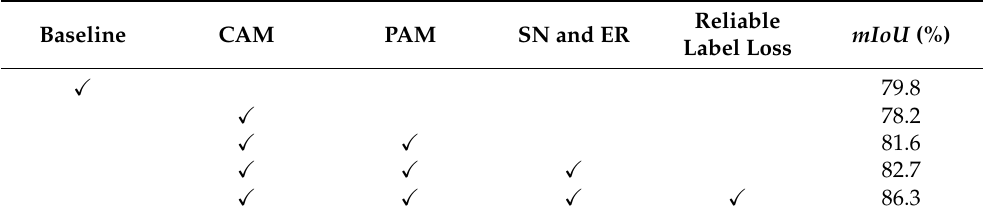
Table 2. Ablation experiments for each part of RSPA. PAM, Pixel Attention Module; SN, Siamese Network; ER, equivariant regularization.